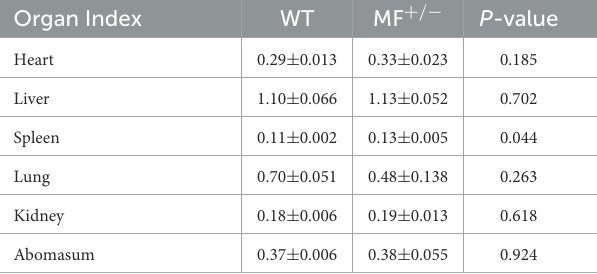
TABLE 1 The conception rate of artificial insemination in different seasons.